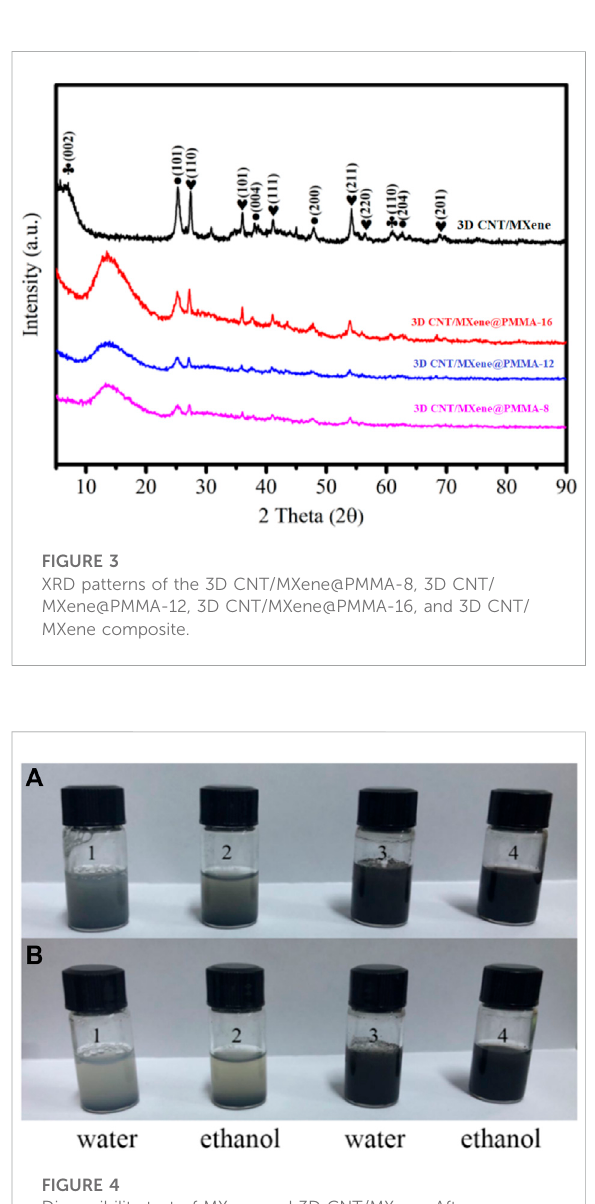
FIGURE 4 Dispersibility test of MXene and 3D CNT/MXene: After shaking (A) , and after resting for 2 h (B) ; Samples 1 and 2 are MXene, Samples 3 and 4 are 3D